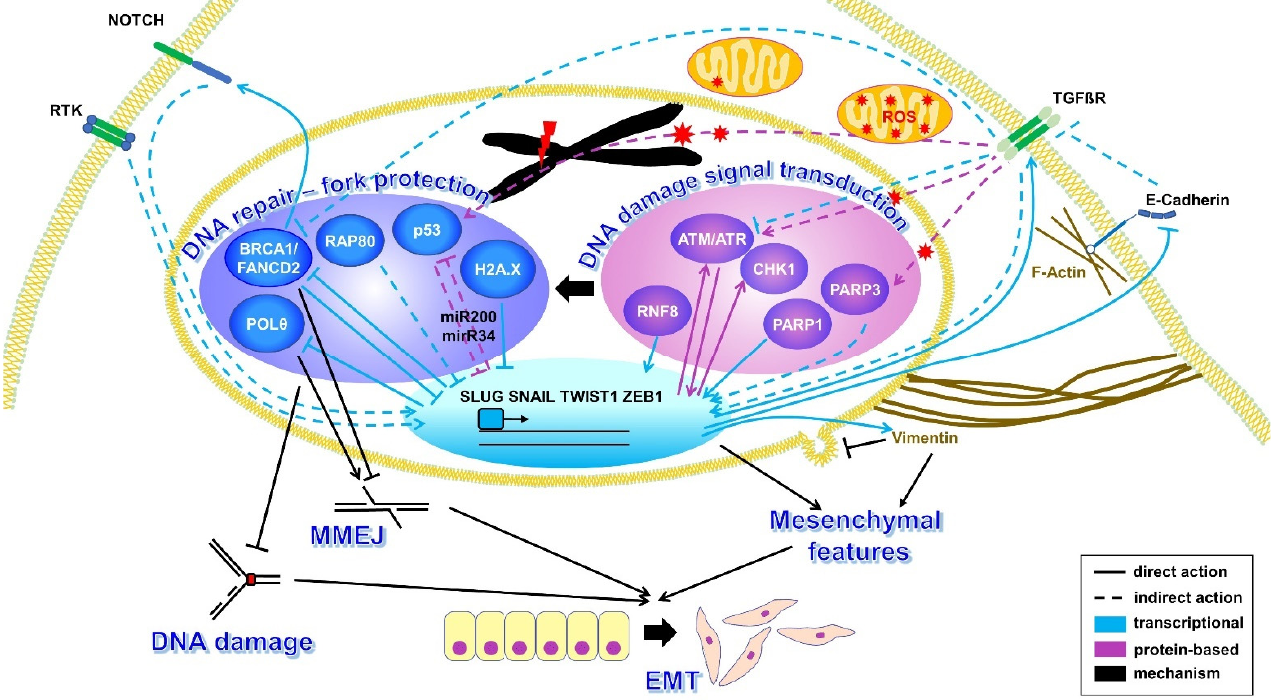
Figure 1. Crosstalk between DNA damage responses and epithelial-mesenchymal transition (EMT) signaling pathways in breast cancer (BC) cells. The transcription factors SLUG, SNAIL, TWIST1 and ZEB1 regulate the expression of multiple factors inducing EMT. In particular, mesenchymal features are induced by the loss of the cell–cell adhesion molecule E-Cadherin and elevated expression of the intermediate filament Vimentin, blocking nuclear rupture. EMT transcription factor-inducing signals are transmitted from the cellular surface by tyrosine kinase receptors (RTKs), NOTCH and TGFßR. TGFß-signaling also activates ATM, p53 and PARP3 via reactive oxygen species (ROS) but also inhibits expression of BRCA1 and ATM. The DNA damage sensing proteins, ATM, ATR, CHK1, PARP1, PARP3 and RNF8, transducing the signal through post-translational protein modifications, promote EMT transcription factors with positive feedback on ATM. Conversely, several proteins involved in DNA repair and/or the protection of DNA replication forks (BRCA1, FANCD2, RAP80, p53, H2A.X) inhibit EMT-inducing transcription factors with negative feedback on the repair proteins polymerase θ , BRCA1 and p53. Accumulation of DNA damage such as that caused by a failure to protect forks and/or to repair them in BRCA1-mutated BC cells triggers EMT. HR dysfunction in these cells de-represses polymerase θ and, therefore, mutagenic repair by microhomology-mediated end joining (MMEJ), which rescues the survival of these cells. For further details, references and abbreviations see Section 2.1 in the main text and Table 1.